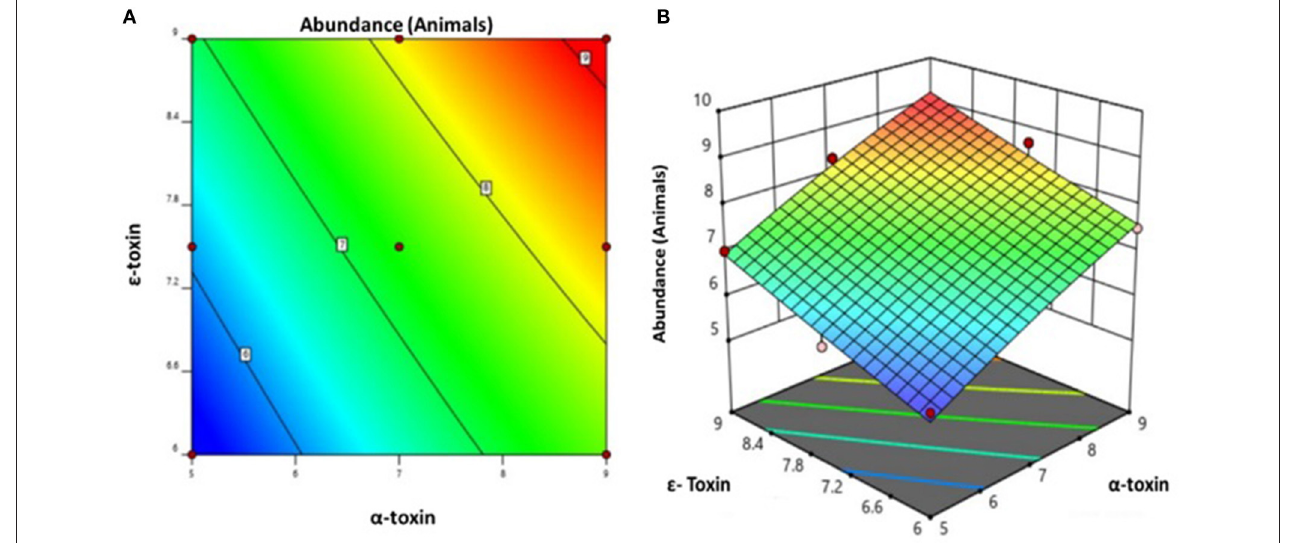
FIGURE 3 | Prevalence of C. perfringens toxinotypes in four different zones of Punjab province in Pakistan (A) contour plot (B) surface plot.